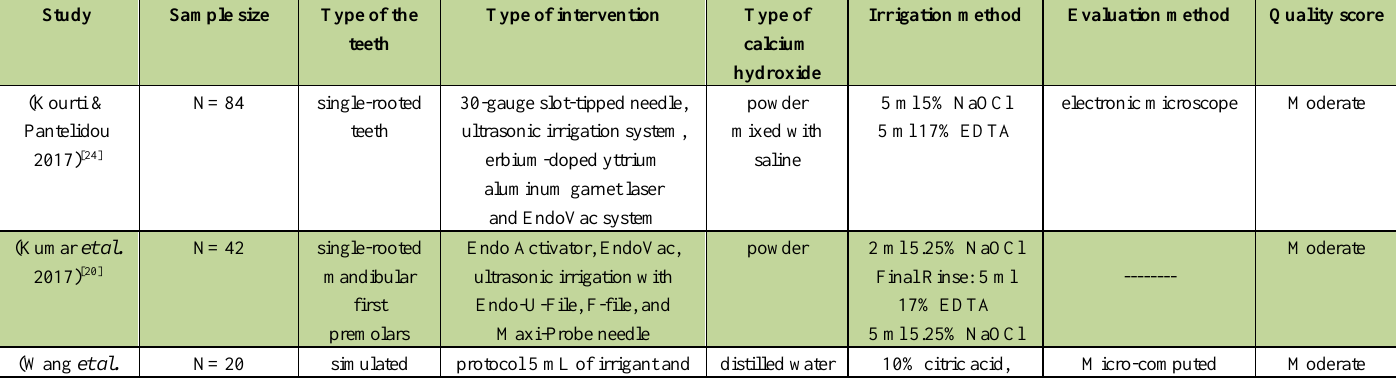
Table 2. Summary of the characteristics of the